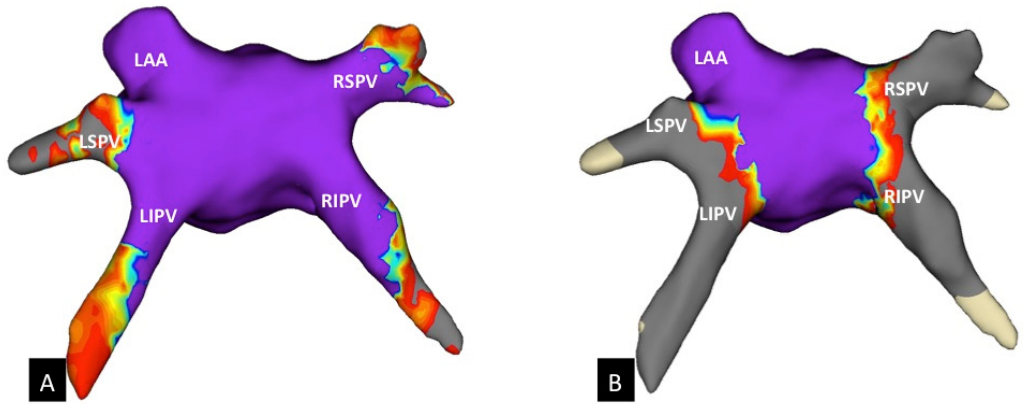
Figure 1. 3D-HD map of the left atrium. ( A ) The initial map before cryoballoon ablation in a superior view. ( B ) Lesion extension after CB-based PVI in a superior view. Note the unablated area at the roof and the posterior wall between the PVs and the antrum of the LSPV. 3D-HD, high-density; RSPV, right superior pulmonary vein; RIPV, right inferior pulmonary vein; LSPV, left superior pulmonary vein; LIPV, left inferior pulmonary vein; LAA, left atrial appendage.